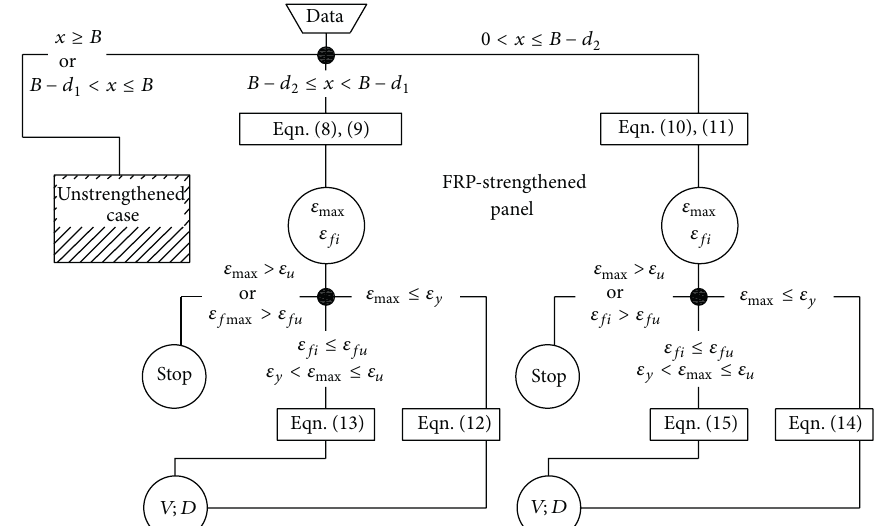
Figure 5: Flowchart of the procedure for FRP-strengthened